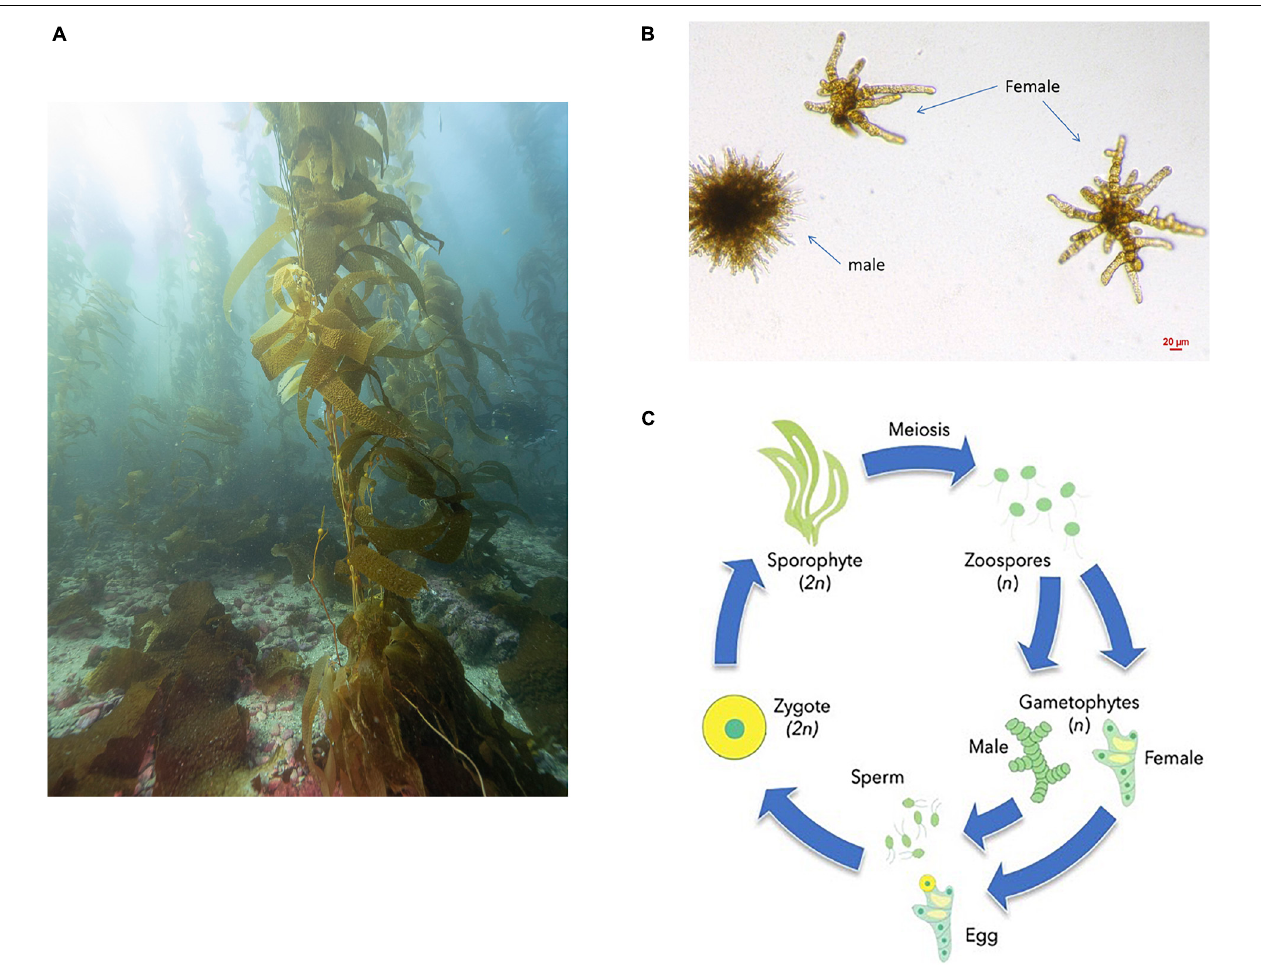
FIGURE 1 | (A) Adult giant kelp diploid sporophyte (Picture courtesy of Maurice Roper). (B) Microscopic giant kelp haploid gametophytes. (C) Giant kelp reproductive cycle: during sexual reproduction, adult sporophytes (2N) produce zoospores (N) through meiosis, which after settling differentiate into sexed gametophytes. Sexual reproduction of gametophytes happens when sperm from a male gametophyte encounters a female gametophyte egg. Fusion will result in an early stage sporophyte completing the cycle. (C) Courtesy of Kelly